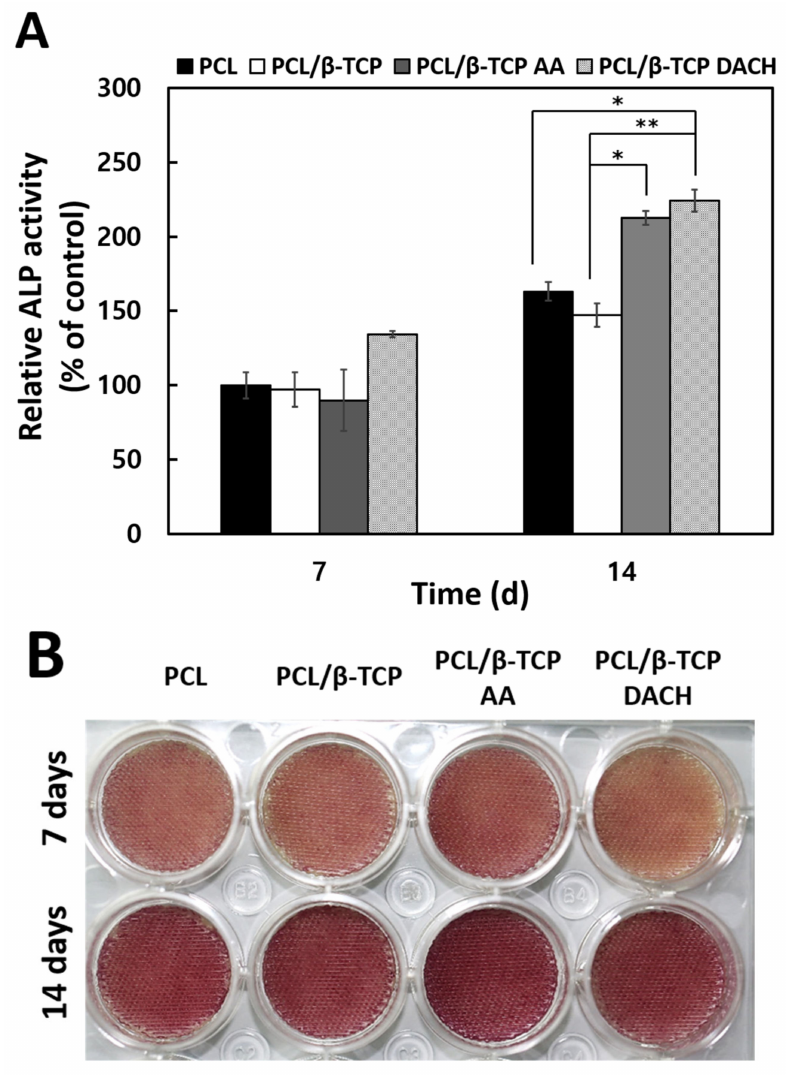
Figure 11. Osteogenic differentiation study: ( A ) ALP activity of MC3T3-E1 cells cultured for 7 and 14 days on the 3D pristine PCL scaffold and PCL/ β -TCP scaffold before and after AA and DACH plasma polymerization ( n = 3, * p < 0.05, ** p < 0.01 compared with the PCL scaffolds on 7 days). Statistical analysis was carried out using One-way ANOVA followed by post-hoc Tukey test. ( B ) ALP staining photographs for the stained pristine PCL, PCL/ β -TCP, and amine plasma polymerized PCL/ β -TCP scaffolds cultured with cells for 7 and 14